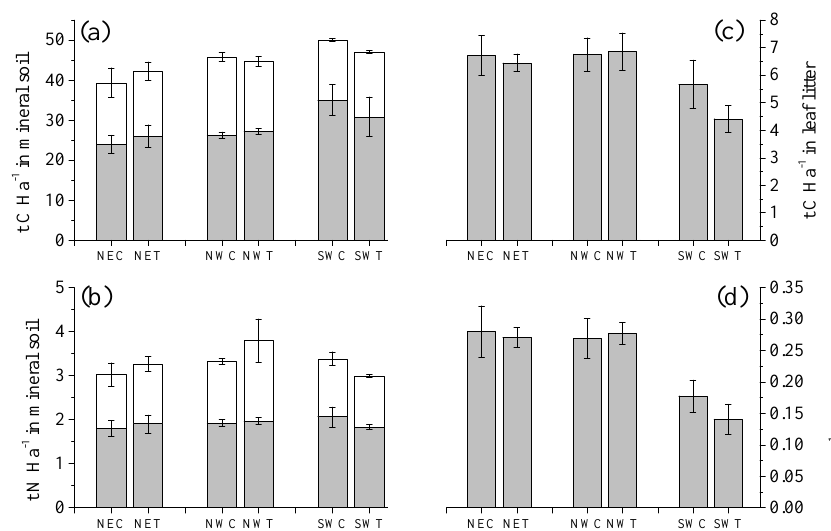
Figure 2. SOC and TN stocks in mineral soil ( a , b ) and leaf litter ( c , d ). Uncertainty is given as the standard error of the mean of three replicated plots. Grey area of stacked columns: mineral soil 0–5 cm; white area of stacked columns: mineral soil 5–10 cm depth. NW, NE, SW: exposure of experimental sites; C: Control, T: Thinning. There were no significant thinning effects on the displayed parameters. The patterns of δ 15 N in mineral soil and leaf litter resembled those observed for total soil N and